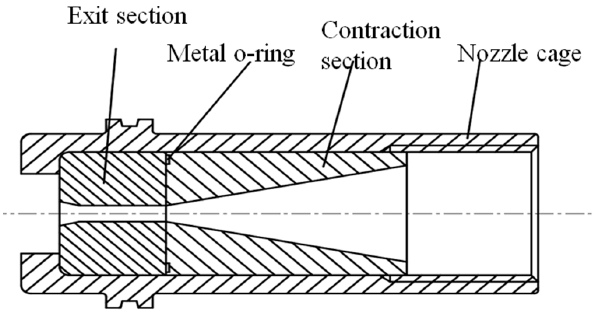
Figure 1. Structure of the nozzle.